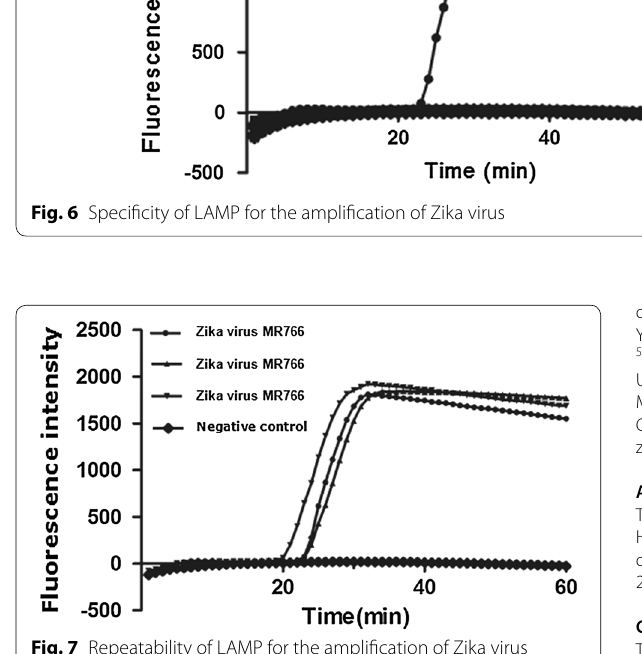
Fig. 7 Repeatability of LAMP for the amplification of Zika